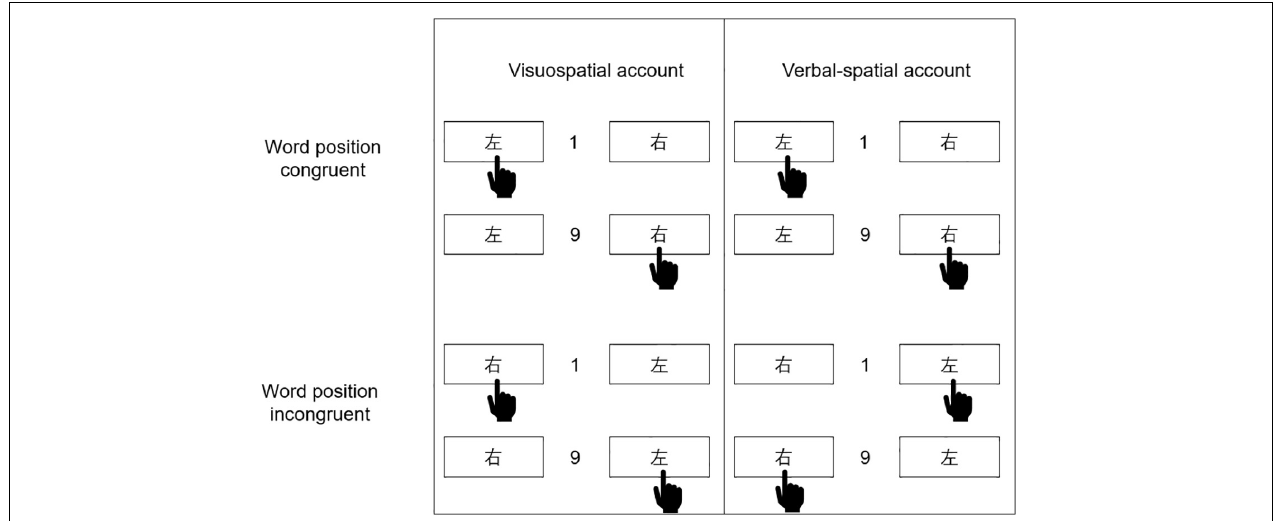
FIGURE 1 | Visuospatial and verbal-spatial account of SNARC effect.